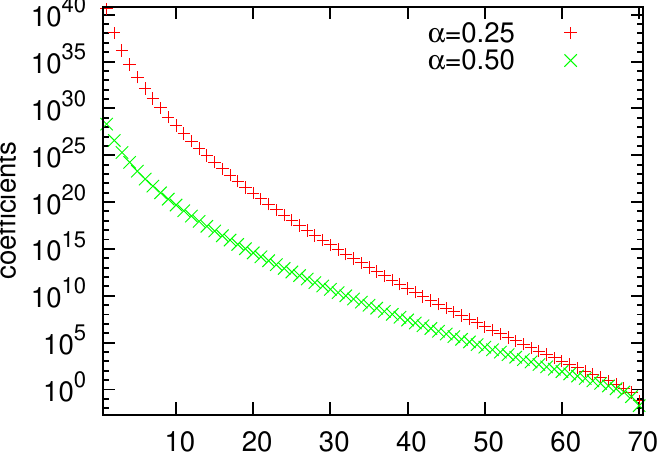
Figure 3. The coefficients − (cid:101) d i in the rational approximation of degree 70 of z − α for the values of α = 1 , 1 2 4